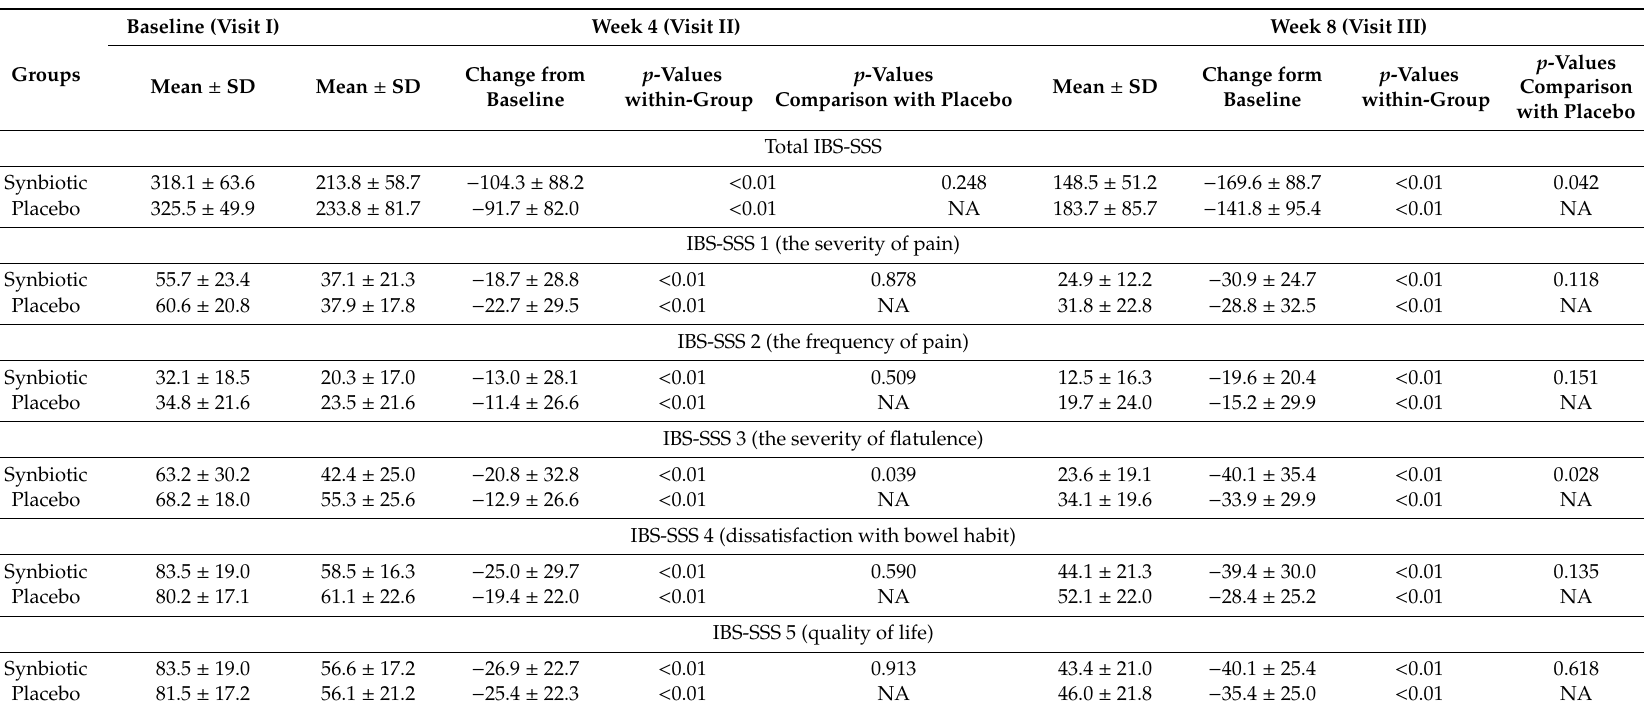
Table 4. The e ff ect of synbiotic intervention on the severity of IBS symptoms assessed with the use of IBS-SSS